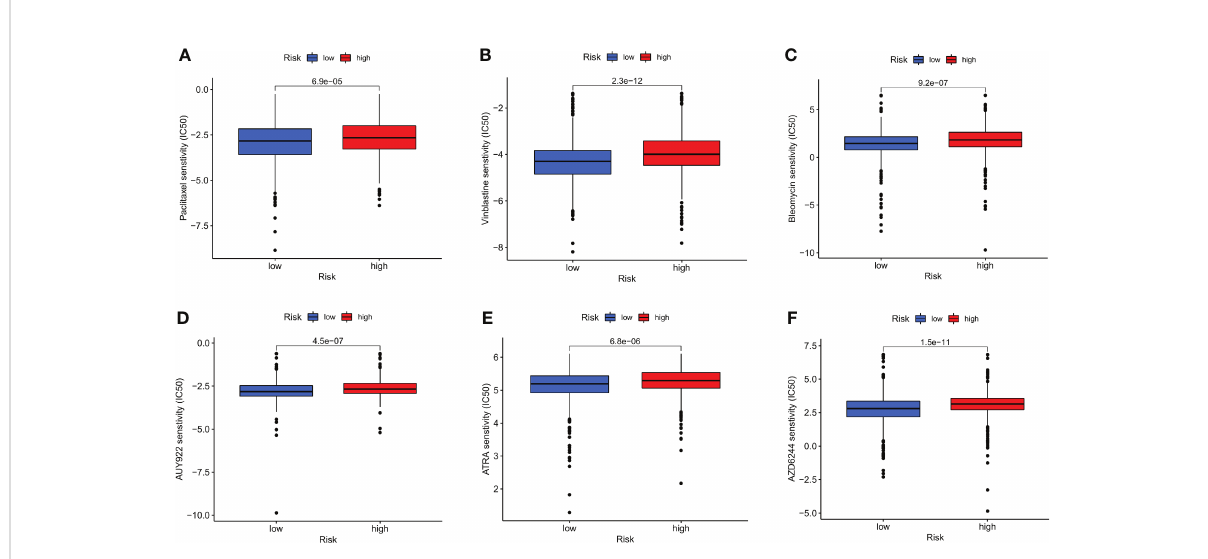
FIGURE 9 Relationships between the CRG score and susceptibility to chemotherapy or targeted therapies for BC. (A) paclitaxel. (B) Vinblastine. (C) Bleomycin. (D) AUY922. (E) ATRA. (F)